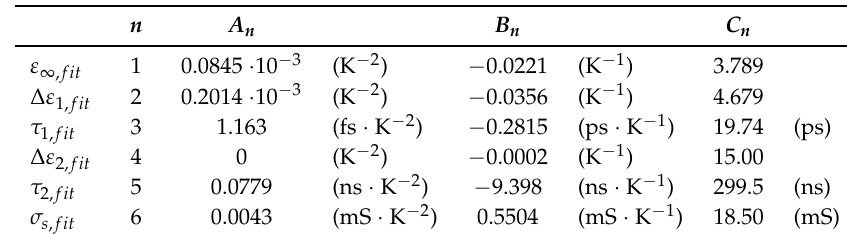
Table 3. Temperature coefficients of the second order polynomial fit to the temperature dependent Cole-Cole parameters of fat.